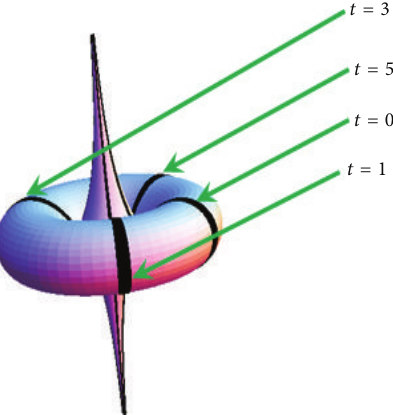
Figure 7: The curvature of the family of curves 𝐶 𝑡 for 𝑠 ∈ [0, 10] , = 1 , 𝑐 = −1 , and 𝑐 = 0 . 𝑡 ∈ [0, 15] , 𝑐 1 2 3